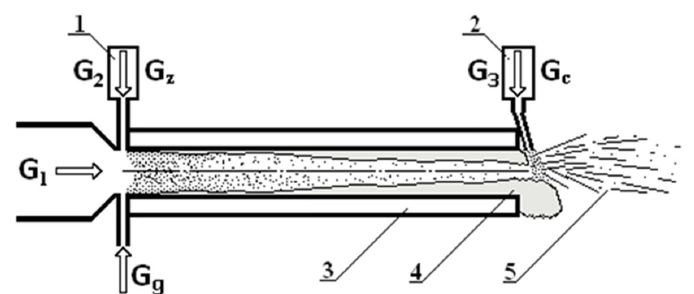
Figure 1. The schematic view of the catalytic fibre production process. 1—the feeder of particles; 2—the feeder of catalytic particles; 3—reactor walls cooled with water; 4—melt flow; 5—produced fibers and granules; G1—air plasma flow from plasma torch; G2—air flow for injection of ceramic materials; G3—air flow for spraying of catalytic particles; Gc—flow of catalytic particles; Gg—propane gas flow; Gz—flow of particles.